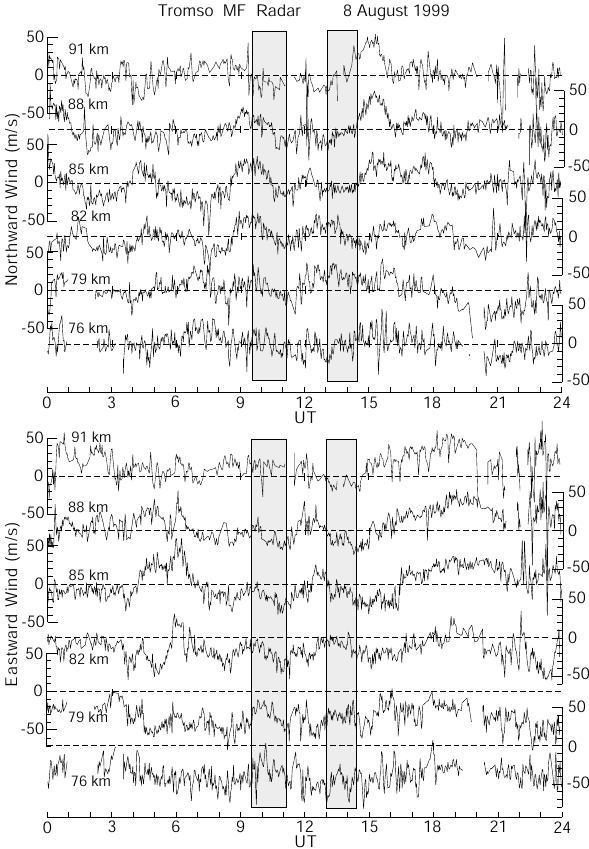
Fig. 4. Time and altitude variations of (upper) northward and (lower) eastward winds observed with the Tromsø MF radar. Two PMSE occurrences detected with the Hankasalmi HF radar are lightly